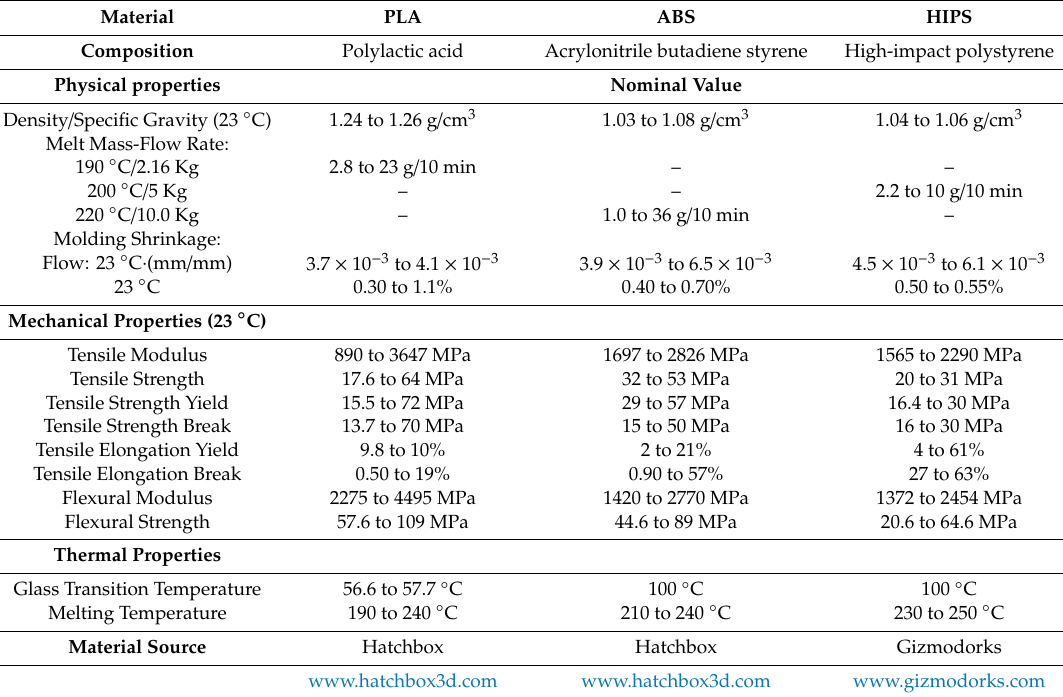
Table 1. Typical properties of ABS, PLA and